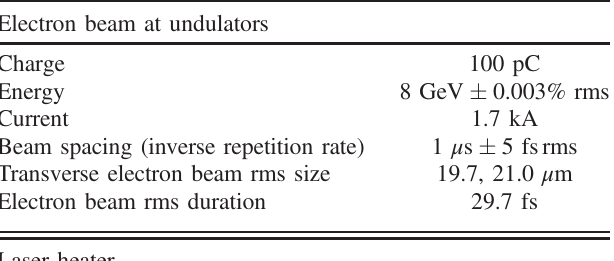
TABLE I. LCLS-II-HE XRAFEL parameters common to all the simulations. Parameters after the (cid:2) symbol denote rms shot- to-shot variation in that parameter.